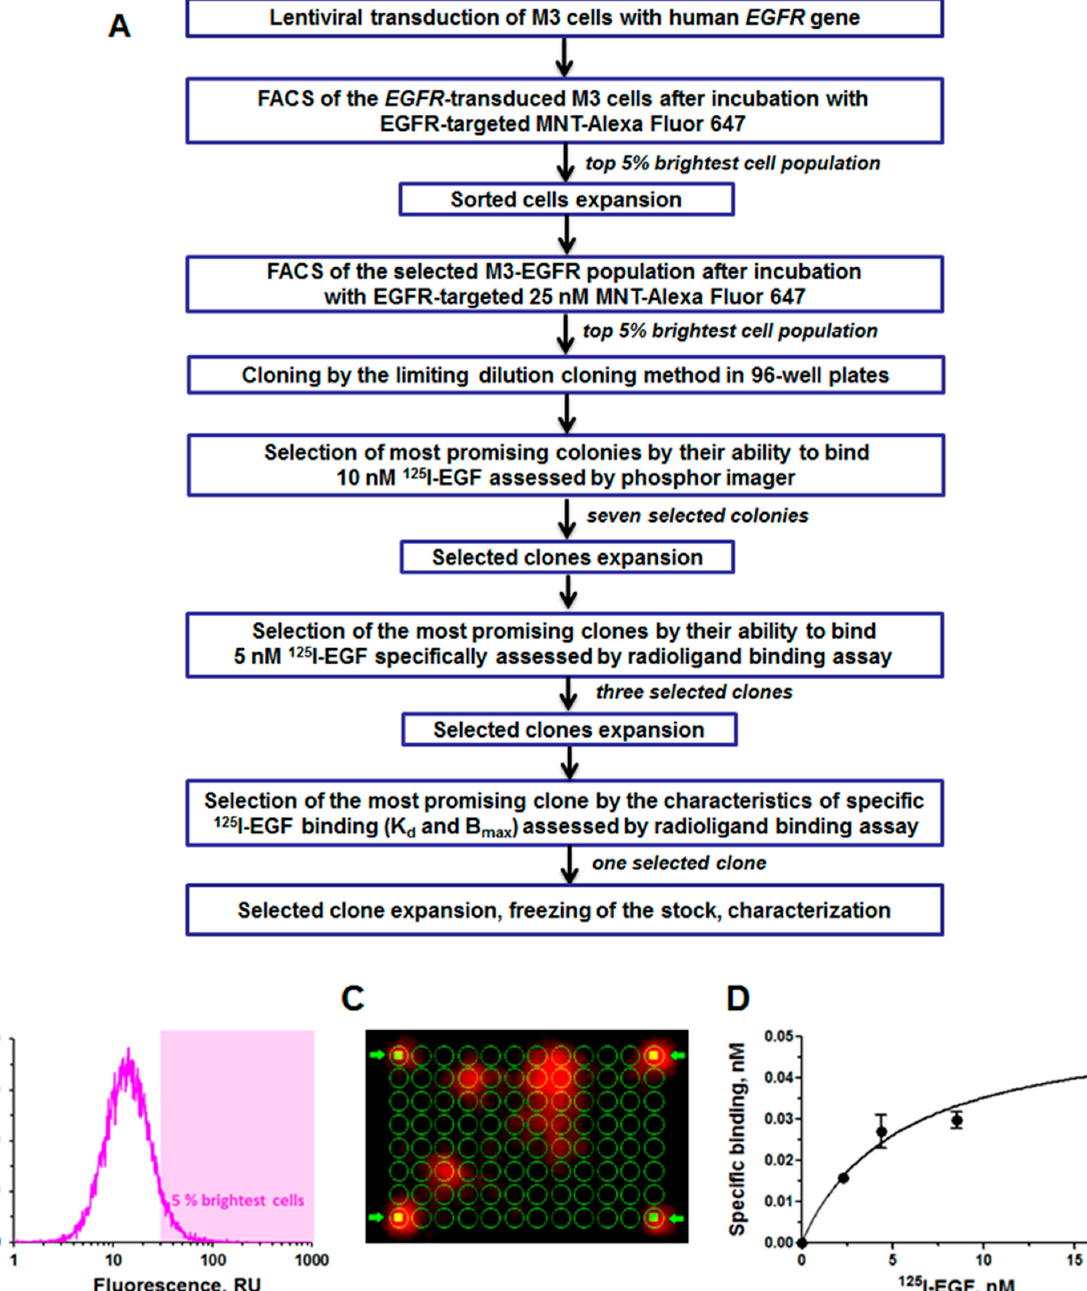
Figure 2. Development and selection of M3 cells with expressing functional epidermal growth factor receptor (EGFR). ( A ) Flow-chart illustrating the selection process step-by-step, ( B ) Fluorescence-activated cell sorting of initial M3-EGFR cells incubated with EGFR-targeted modular nanotransporter labeled with Alexa Fluor 647, the top 5% brightest cells that were sorted and used for further subcloning are highlighted. ( C ) Radioactivity distribution obtained by Storm 865 phosphorimager on the storage phosphor screen incubated with 96-well plate with M3-EGFR colonies after 24 h incubation of this 96-well plate with 10 nM 125 I-EGF. The four bright marks pointed by arrows at the corners of the screen were made manually by applying radioactivity into the corner wells of the plate for adjustment 96-well plate green mask. ( D ) Radioligand 125 I-EGF binding to finally selected M3-EGFR clone.